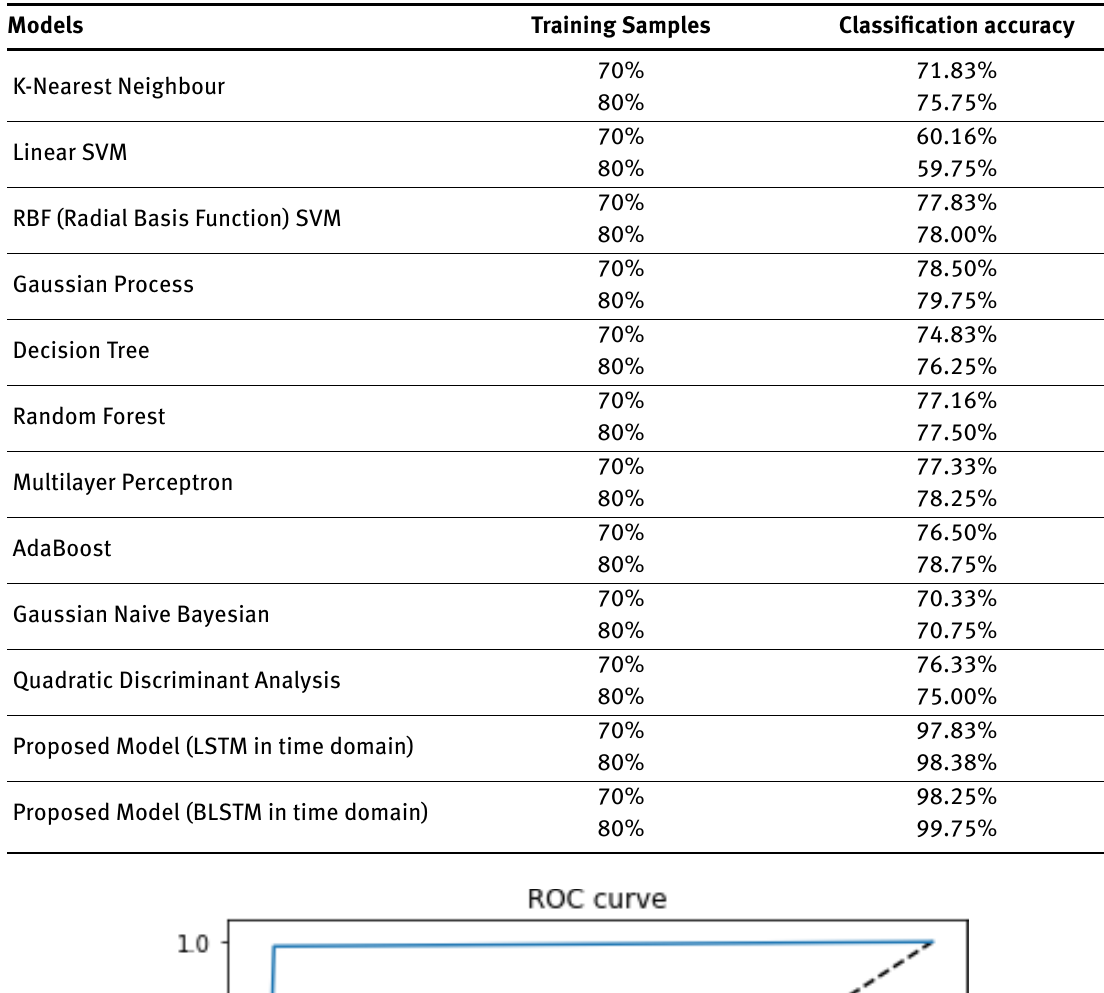
Table 5: Comparison of performance of Proposed models with classical machine learning models Models